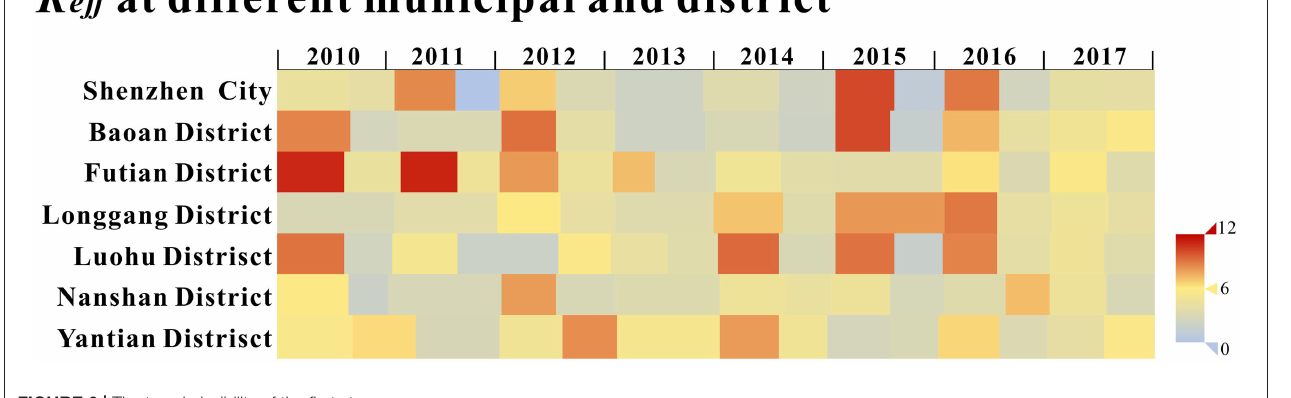
FIGURE 6 | The transimissibility of the first stage.